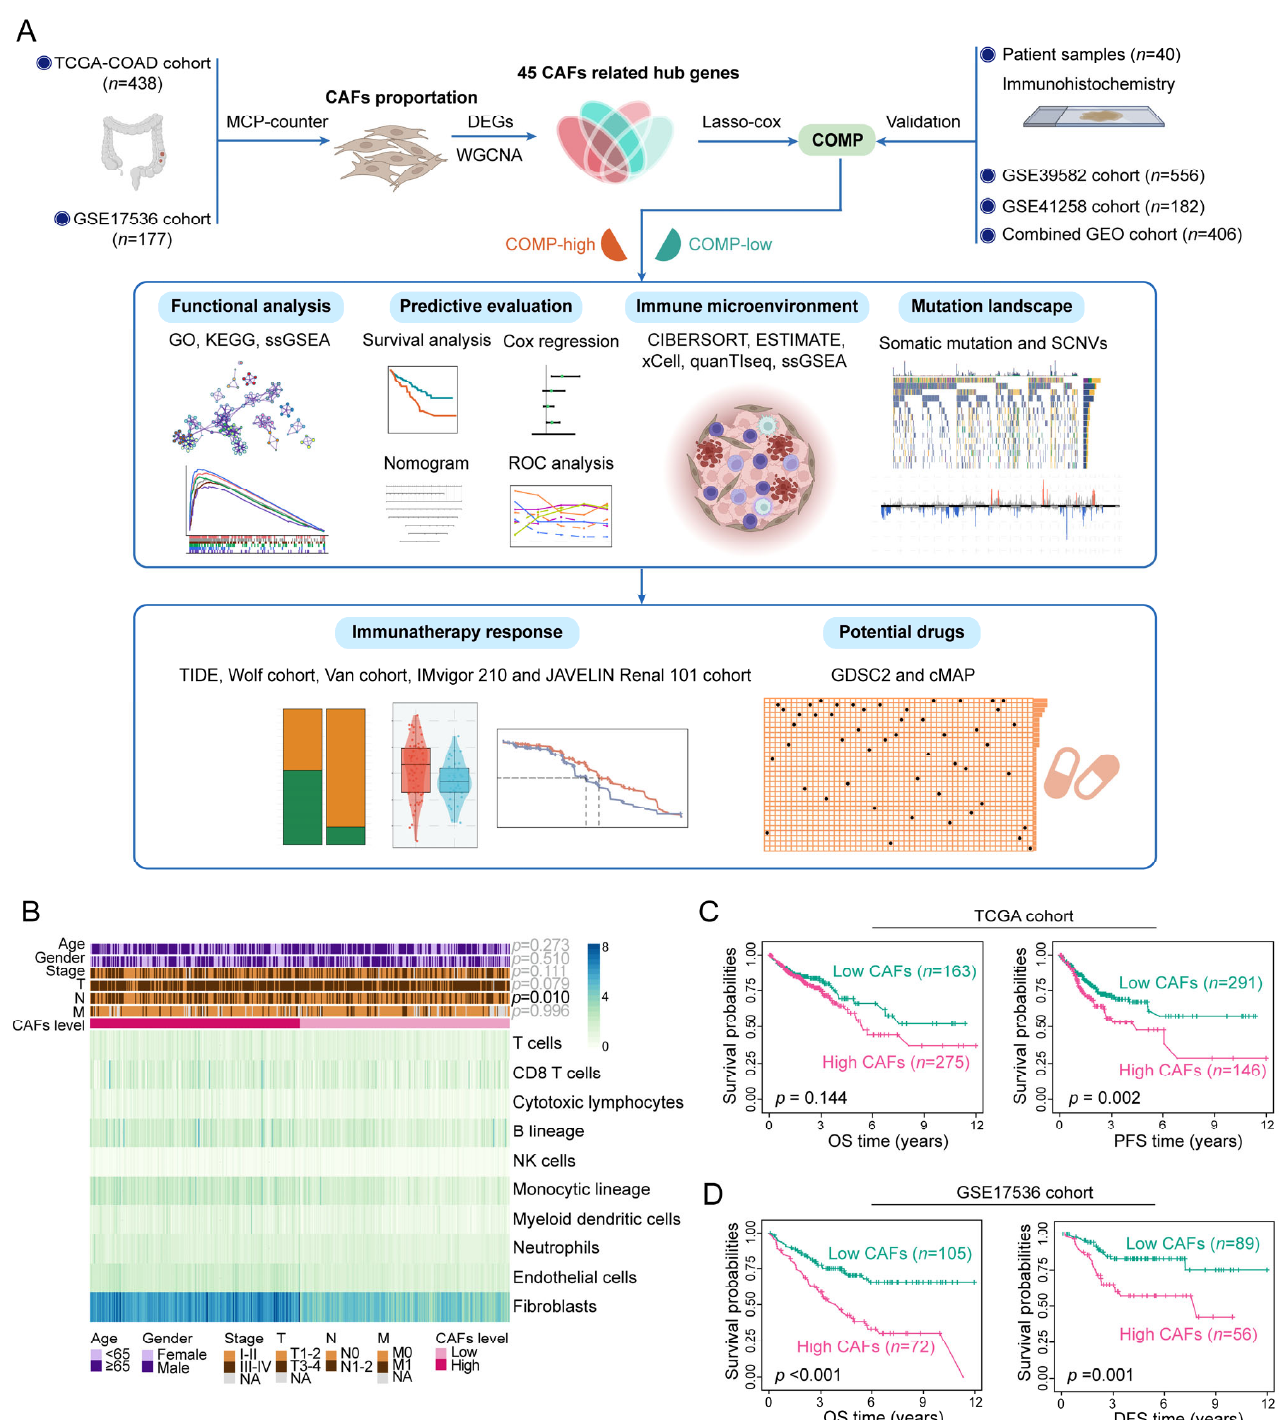
Figure 1. Assessment of clinical features and the immune landscape associated with CAFs. ( A ) The whole flowchart of the study design; ( B ) Various TME cell abundances in the TCGA cohort are shown in the heat map. Associations between CAFs level and clinicopathological characteristics are also illustrated as an annotation; ( C ) K–M plots of OS and PFS for two CAFs subtypes in the TCGA dataset; ( D ) K–M plots of OS and DFS for two CAFs subtypes in the GSE17536 dataset.